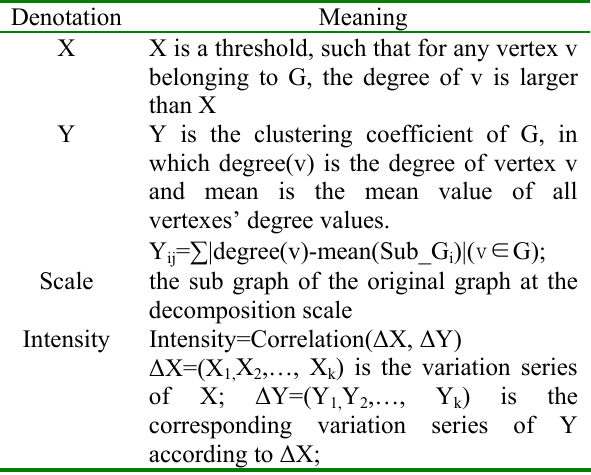
Table 1. Denotation of complex network’s intervention rule Denotation